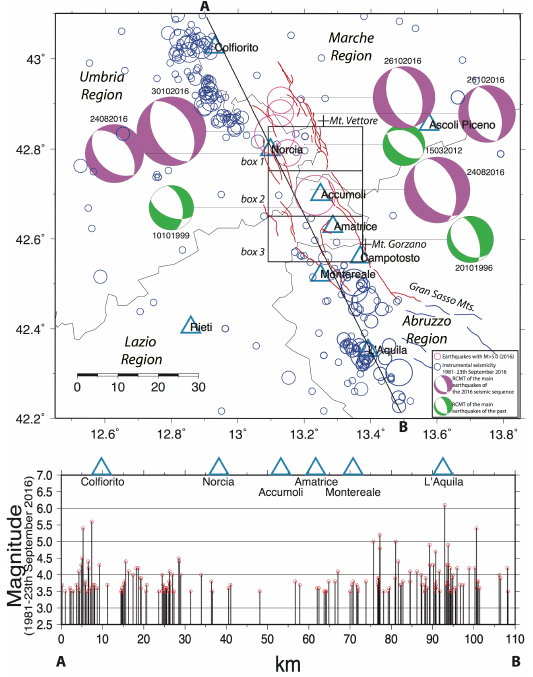
Figure 3. Top: Earthquake fault-plane solutions of major events (CMT solutions) and patterns of seismicity with Ml >=3.5 in the central Apennines, Italy, from 1981 to the 23th August 2016. CMT solutions for the mainshock and greater aftershock of the Amatrice seismic sequence. Red lines represent the faults mapped by EMERGEO Working Group, 2016. Bottom: the Magnitude of the earthquakes has been projected onto a NW-SE vertical spatial section (15 km thick) along the trend of the Apennines (trace in the upper panel) underlying the lack of strong seismicity in the study